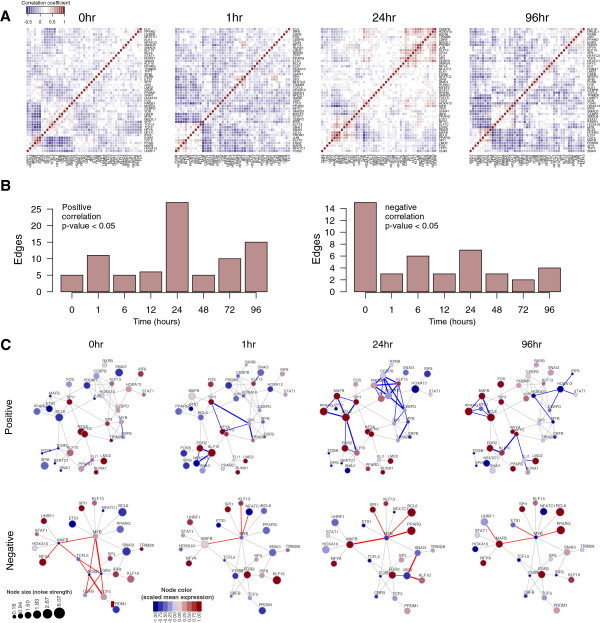
Dynamic rewiring within the co-expression network during differentiation. (A) Heatmap matrix of Spearman correlation analysis of 45 TFs across 120 single-cells at time points 0 h, 1 h, 24 h, and 96 h post differentiation and (B) quantification of significant edges (positive and negative) at each time point. (C) Co-expression networks showing putative relationship between TFs in all time points but highlighting activating or positive correlations (top row: blue edges) and antagonistic or negative correlations (bottom row: red edges) for time points 0 h, 1 h, 24 h, and 96 h post-PMA stimulation (P value <0.01). The node-colors indicate mean gene expression (scaled: blue = low expression; light brown = moderate expression; dark brown = high expression) while the node sizes indicate single-cell gene expression variations (small nodes = low variation; big nodes = high variation).